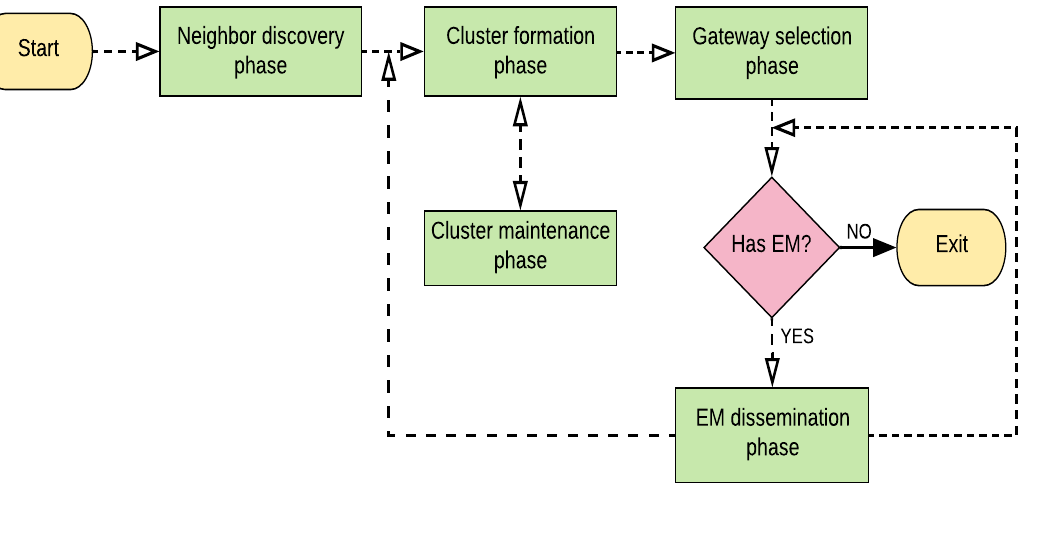
Figure 2. Procedural flowchart of